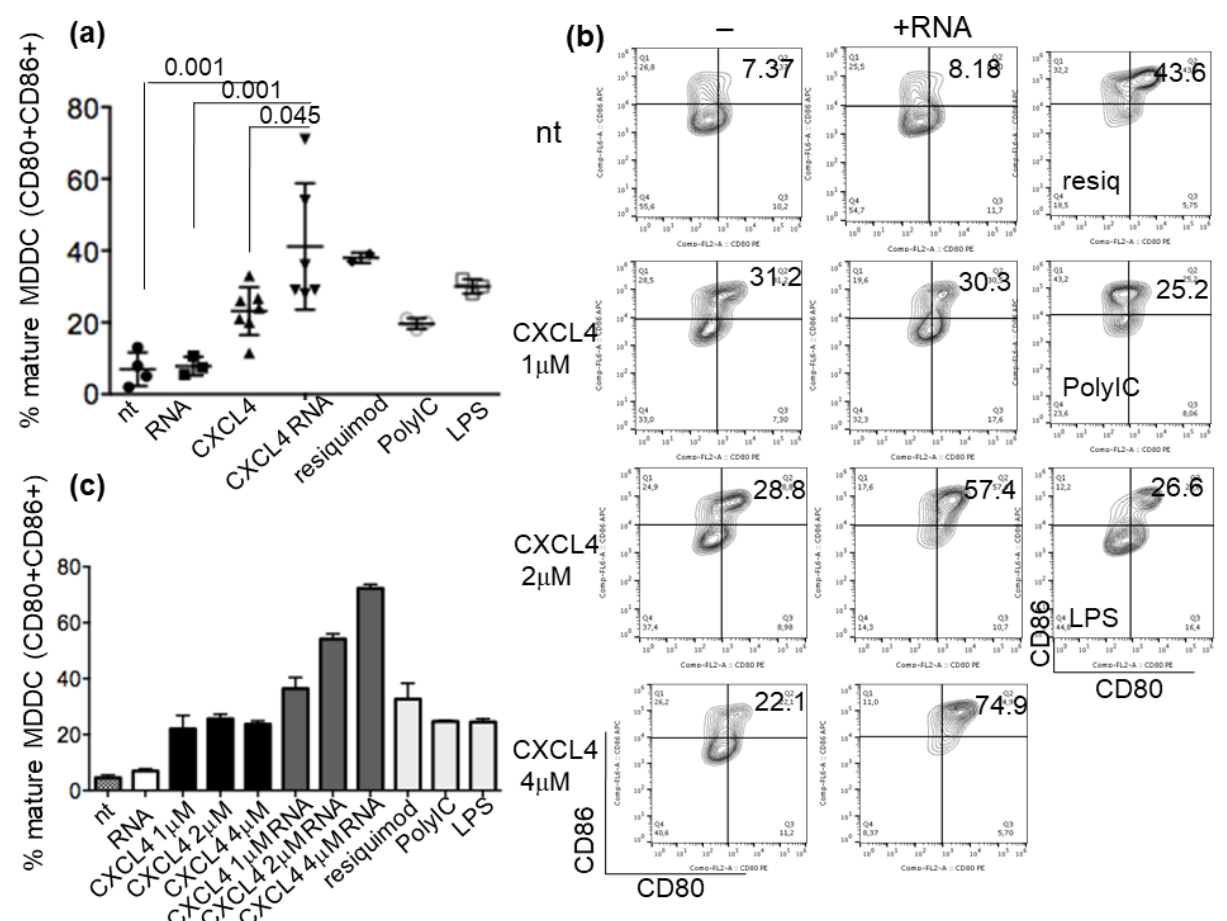
Figure 3. MDDCs are stimulated to maturity by CXCL4-RNA complexes. MDDCs were either untreated (nt) or treated with RNA alone or CXCL4 alone or with different amounts of CXCL4-RNA complexes ( b , c ) or with TLR agonists: resiquimod (TLR8), PolyIC (TLR3), or LPS (TLR4). MDDC maturation was evaluated by flow cytometry and is expressed as a percentage of double-positive (CD80 + CD86 + ) cells. ( a ) Results from 3 to 5 experiments (depending on the stimulation) performed with the MDDCs of different donors. p -values were by Mann–Whitney’s test. ( b ) Flow cytometry representative plots of dose–response to different concentrations of immune complexes. In ( c ), the same representative experiment was visualized as histograms and standard errors (vertical bars), which were performed in